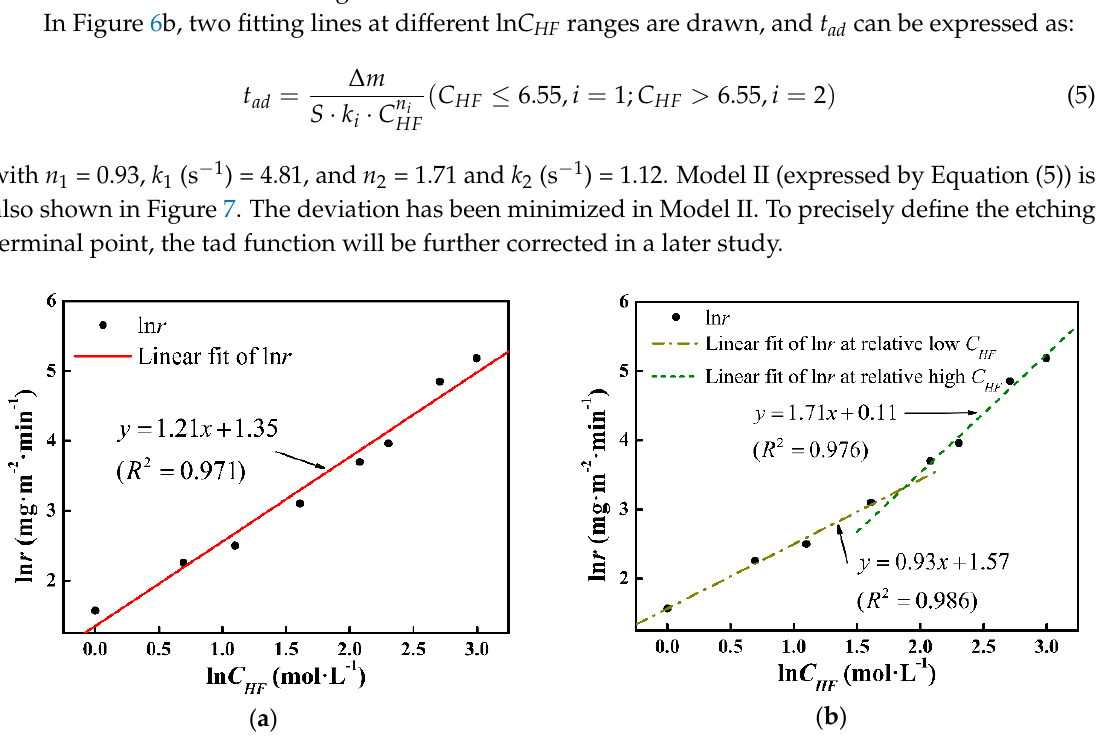
Figure 6. Arrhenius fitting of ln r in ln C HF domain at ( a ) whole range and ( b ) department ranges.